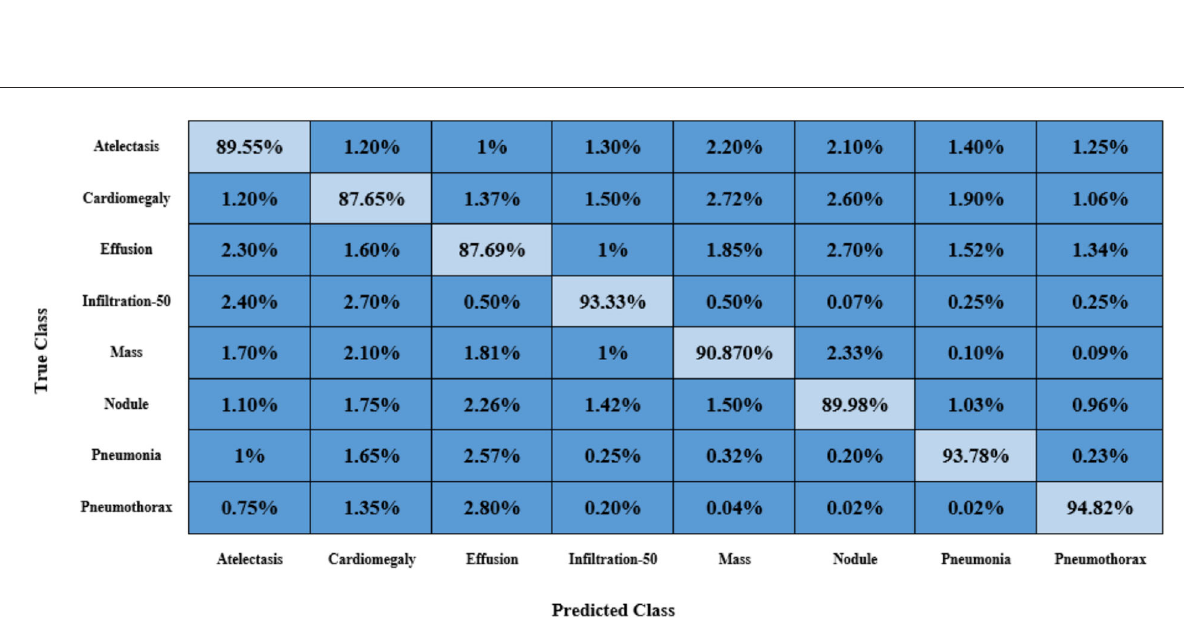
FIGURE13 Confusion matrix obtained for CXR disease classification with the custom